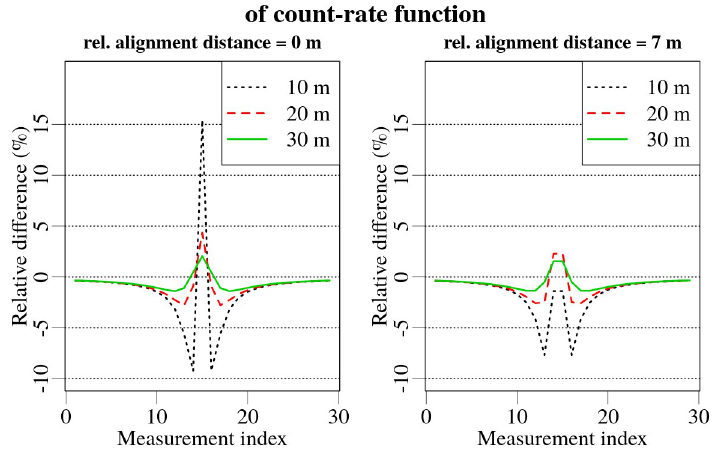
Fig 6. Comparison of relative point-by-point differences between integrated and point estimates of the count rate function for different offsets and distances to the source.